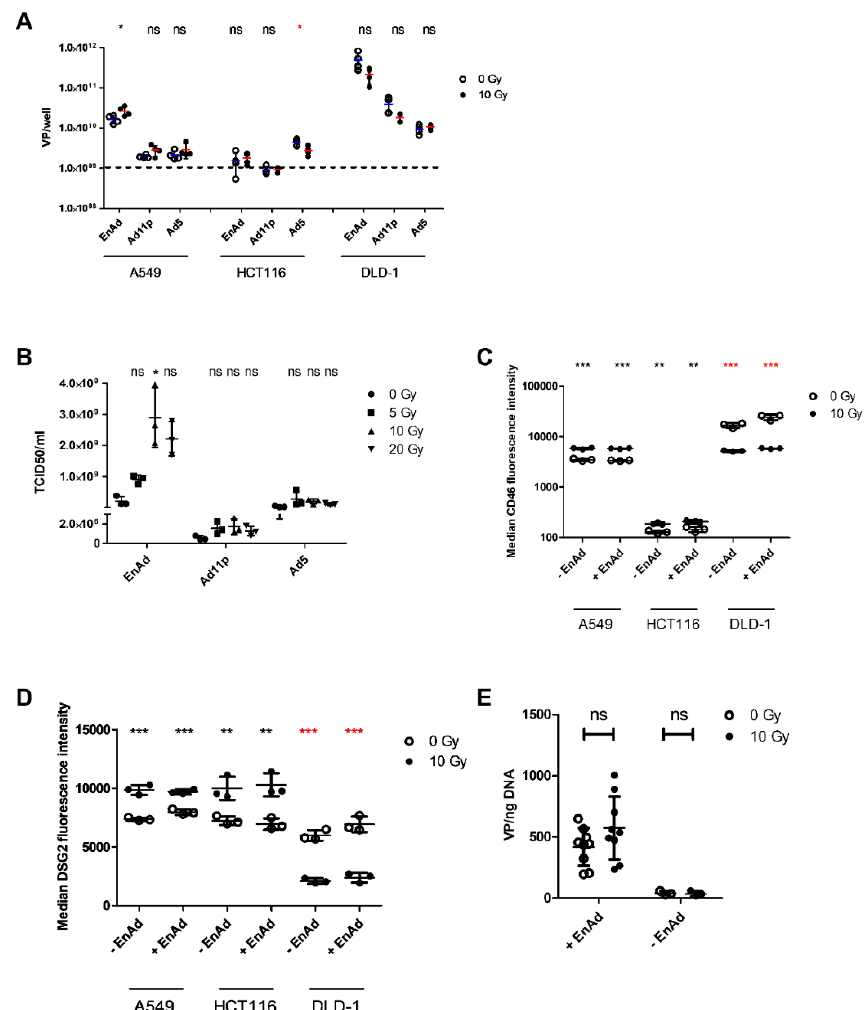
Figure 1. Irradiation increases EnAd genome replication and particle production. ( A ) Viral genomes were quantified at 72 h post-infection (p. i.) in combined supernatant and lysate of A549, HCT116, and DLD-1 cells mock-infected or infected with EnAd-SA-GFP, Ad11p, or Ad5 at an MOI of 0.1. Cells were being irradiated at 10 Gy 24 h post-infection. Genomes were detected using hexon- (EnAd / Ad11p) or fibre-specific (Ad5) primers and probe. Data represents biological replicates ± SD. ( B ) TCID 50 / mL was quantified for supernatant harvested 5 days p. i. from A549 cells mock-infected or infected with EnAd-SA-GFP, Ad11p or Ad5 and irradiated 24 h p. i. at 0, 5, 10 or 20 Gy. Data shows mean ± SD of three experimental repeats, each point representing the mean of three biological replicates within a single experimental repeat. ( C ) CD46 or ( D ) DSG2 median fluorescence levels were measured 24 h after irradiation. A549, HCT116, or DLD-1 cells were infected with EnAd-SA-GFP at an MOI of 0.1 at 24 h before irradiation with 10 Gy. Data represents biological replicates ± SD of a single representative experiment repeated three times. ( E ) A549 cells were irradiated with 10 Gy 18 h prior to seeding in 12-well plates. At 6 h post-seeding, cells were infected with EnAd-SA-GFP at an MOI of 0 or 0.1. At 2 h post-infection, cells were washed twice before extracting and quantifying DNA for viral genomes by qPCR using hexon-specific primers and probes. Data represent biological replicates ± SD from a single experiment representative of three repeats. Significance was evaluated using ( A , E ) unpaired two-sided t-test, ( B ) Kruskal–Wallis test with Dunn’s post-hoc testing, ( C , D ) two-way ANOVA with Bonferroni post-test. * p < 0.05, ** p < 0.01, *** p <